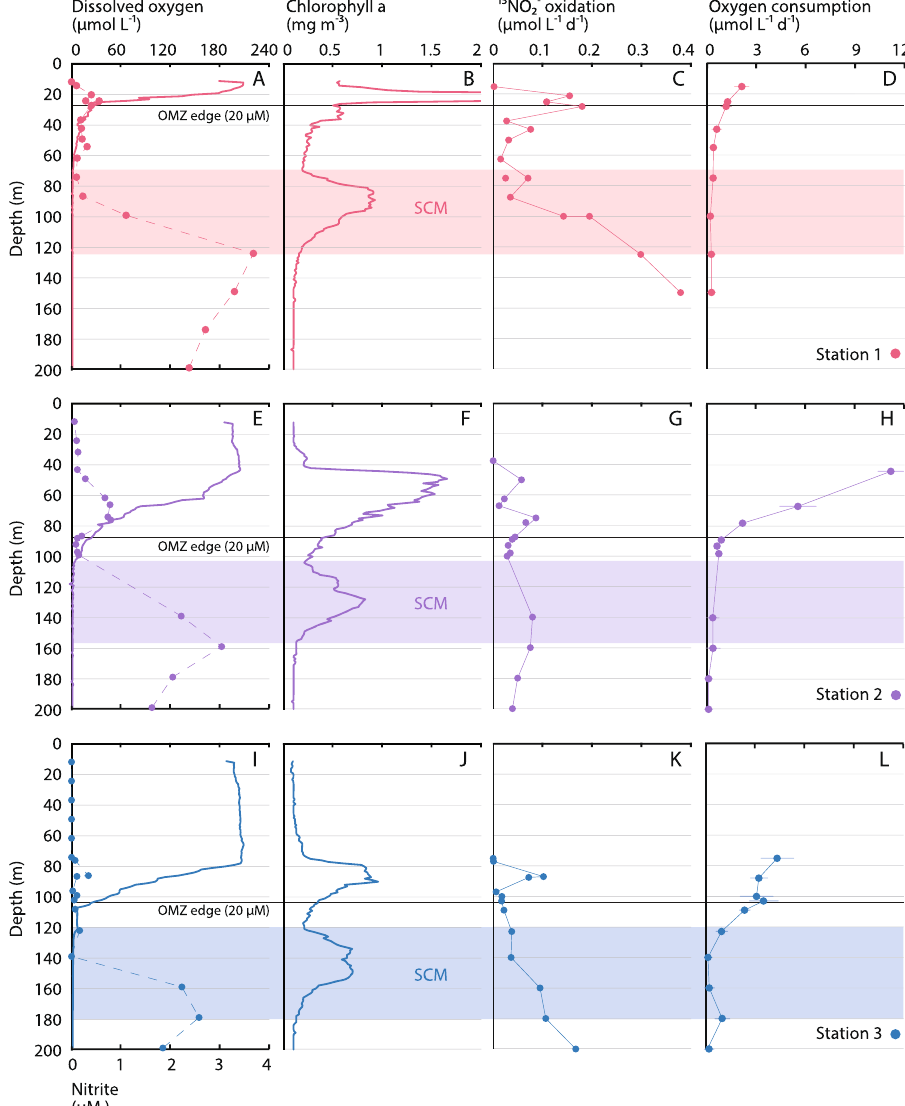
Fig. 2 Biogeochemical depth pro fi les. Pro fi les of A , E , I dissolved oxygen (solid lines) and nitrite (data points connected by dashed lines), B , F , J chlorophyll a , C , G , K nitrite oxidation rates, and D , H , L oxygen consumption rates (OCR; data presented as mean values of fi ve independent replicates ±1 SD) show consistent variation across A – D Station 1, E – H Station 2, and I – L Station 3 (denoted by different colors). Black horizontal lines denote the depth of the oxygen minimum zone (OMZ), and shaded areas show the secondary chlorophyll maximum (SCM) at each station. Rates measured below the SCM should be considered potential rates (see main text). Maximum chlorophyll values at Station 1 plot